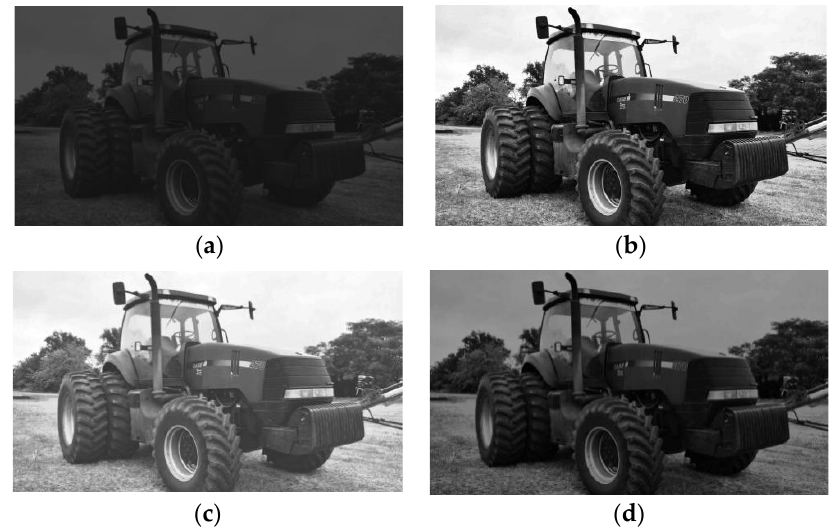
Figure 5. Impacts of A and B on brightness and contrast: ( a ) original; ( b ) [0, 255]; ( c ) [50, 255]; ( d ) [0, 150].